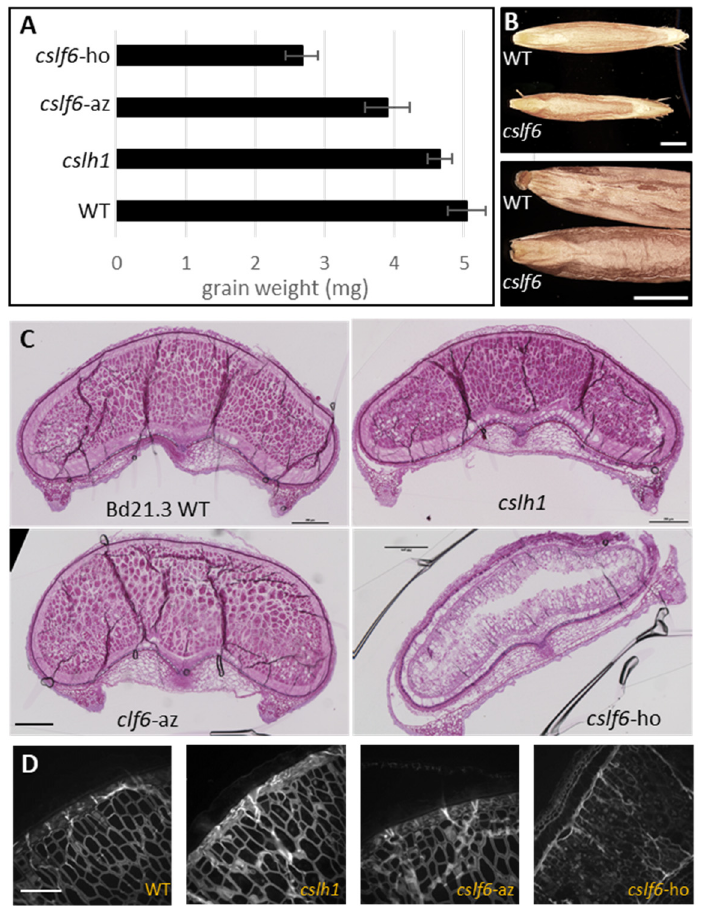
Figure 6. Morphological characterization of mutant grains. ( A ): Average weights of wild type and mutant grains (mean of 10 grains, n = 10). ( B ): Stereomicroscopic images of wild type and homozygous cslf6 mutants showing the size and external aspect of grain. Scale bar = 1 mm. ( C ): Cross-sections of wild type and mutant grains (15 days of flowering) stained with Toluidine blue. Scale bar = 200 µm. ( D ): Calcofluor staining of wild type and mutant grains (15 days after flowering). Scale bar = 50 µm. cslf6 -ho: homozygous cslf6 mutant; cslf6 -az: azygous cslf6 mutant.